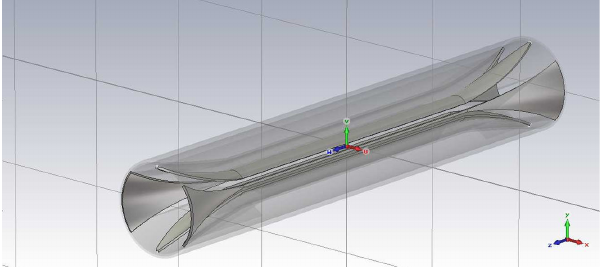
FIG. 13. The model of the strip line kicker for the SRF gun, which is 250 mm long with a 150 mm strip and 50 mm taper at each side. The structure consists of two strip lines with four 50 Ω ports and two ground fenders for homogenizing the field inside the